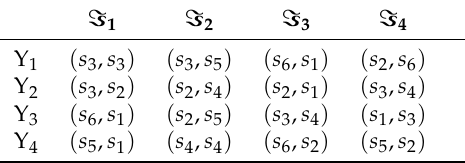
Table 8. Decision matrix R 3 by expert Z 3